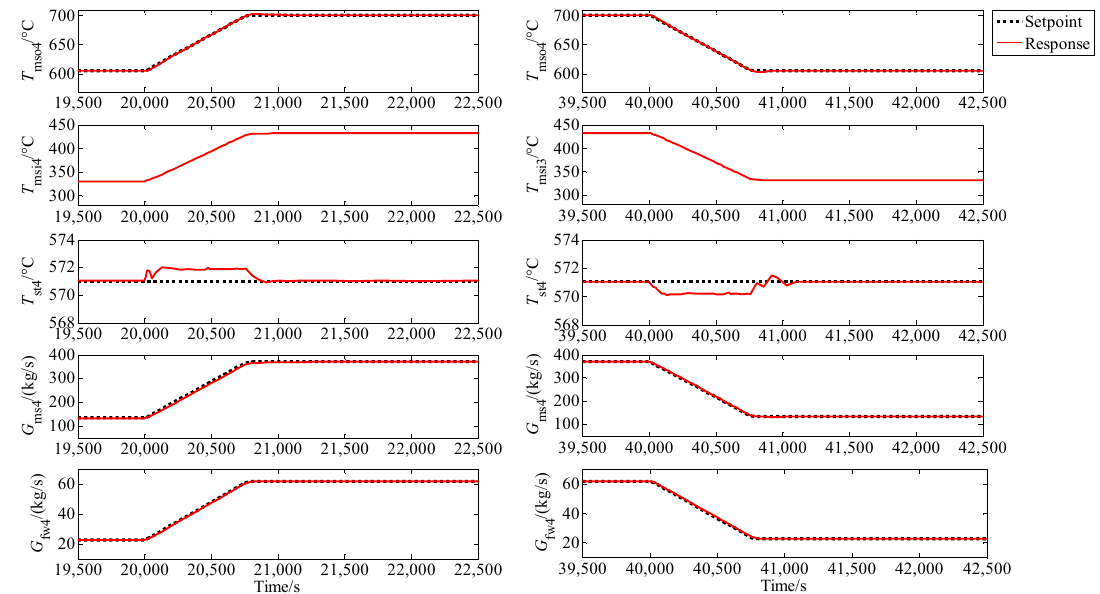
Figure 13. Responses of 2# STP-based OTSSS, T mso4 : receiver outlet molten salt temperature, T msi4 : receiver inlet molten salt temperature, T st4 : live steam temperature, G ms4 : primary molton salt flowrate, G fw4 : secondary feedwater flowrate. Energies 2017 , 10 , 1912